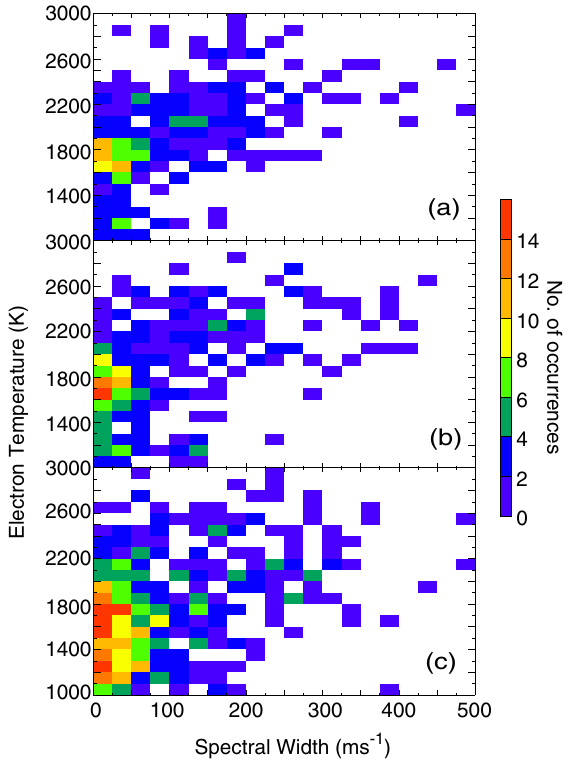
Fig. 9. Line plots comparing co-located and simultaneous mea- surements of electron temperature from the three incoherent scatter beams and spectral width from beam 9, (a) ESR UHF, (b) EISCAT VHF beam 1, (c) EISCAT VHF beam 2. The locations of these in- tersecting measurements have been chosen within the range 71 ◦ N to 72 ◦ N, and at an altitude of ∼